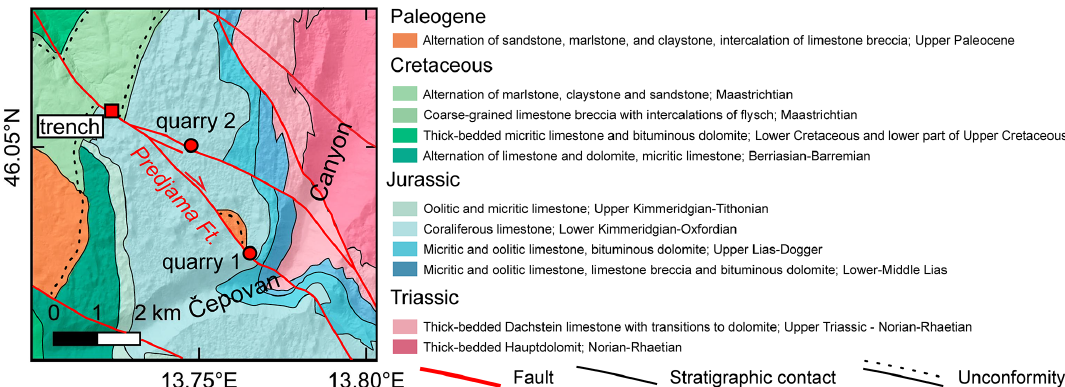
Figure 4. Geological map of the Predjama Fault trench site. Modified from the 1:250000 geological map of Buser (2009). Same extent as the inlet in Fig.